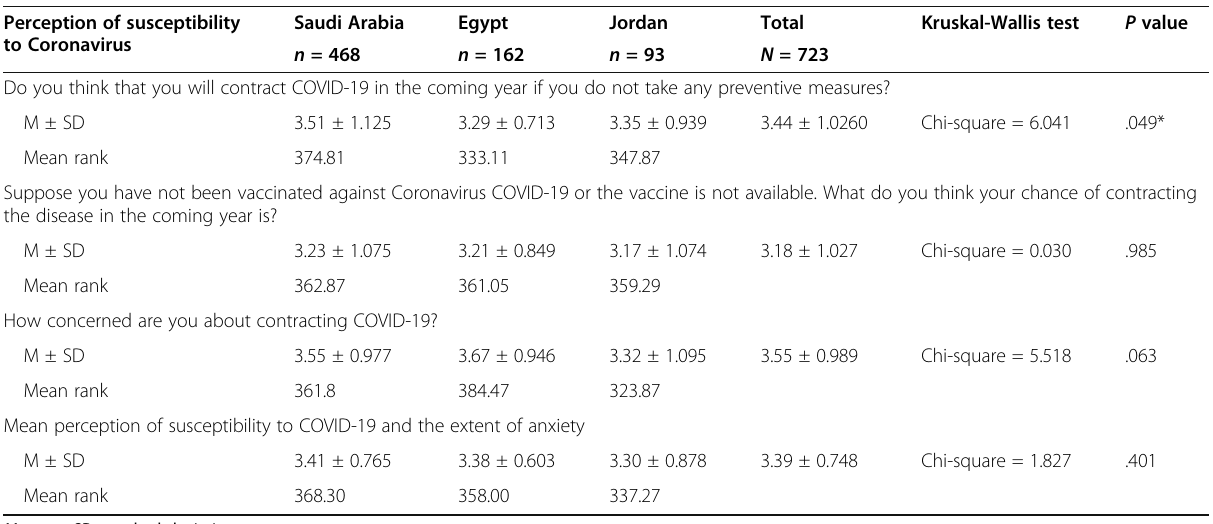
Table 6 Differences in mean “ perception of susceptibility to COVID-19 and the extent of anxiety ” scores, according to country ( N =